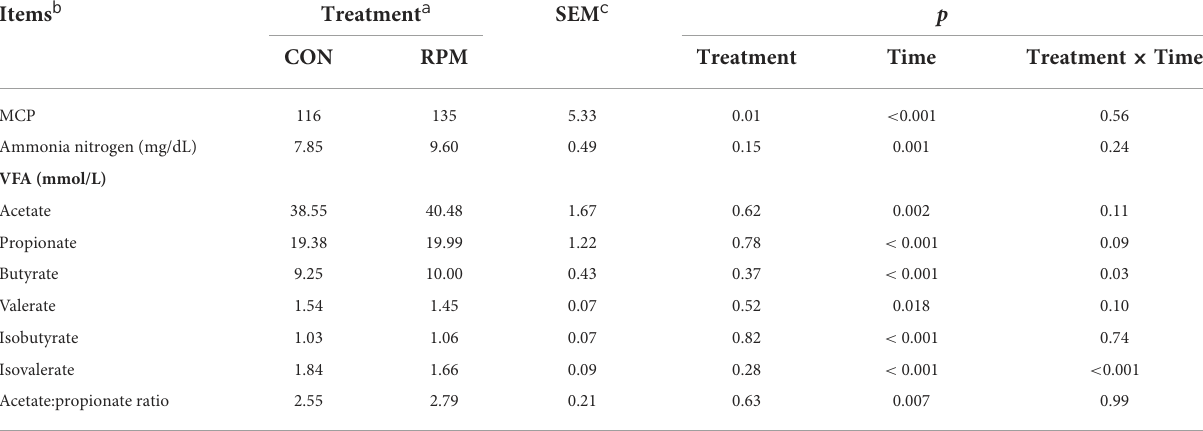
TABLE 5 Effects of supplementing with rumen-protected methionine (RPM) on the Rumen Fermentation Products of dairy cows. Items b